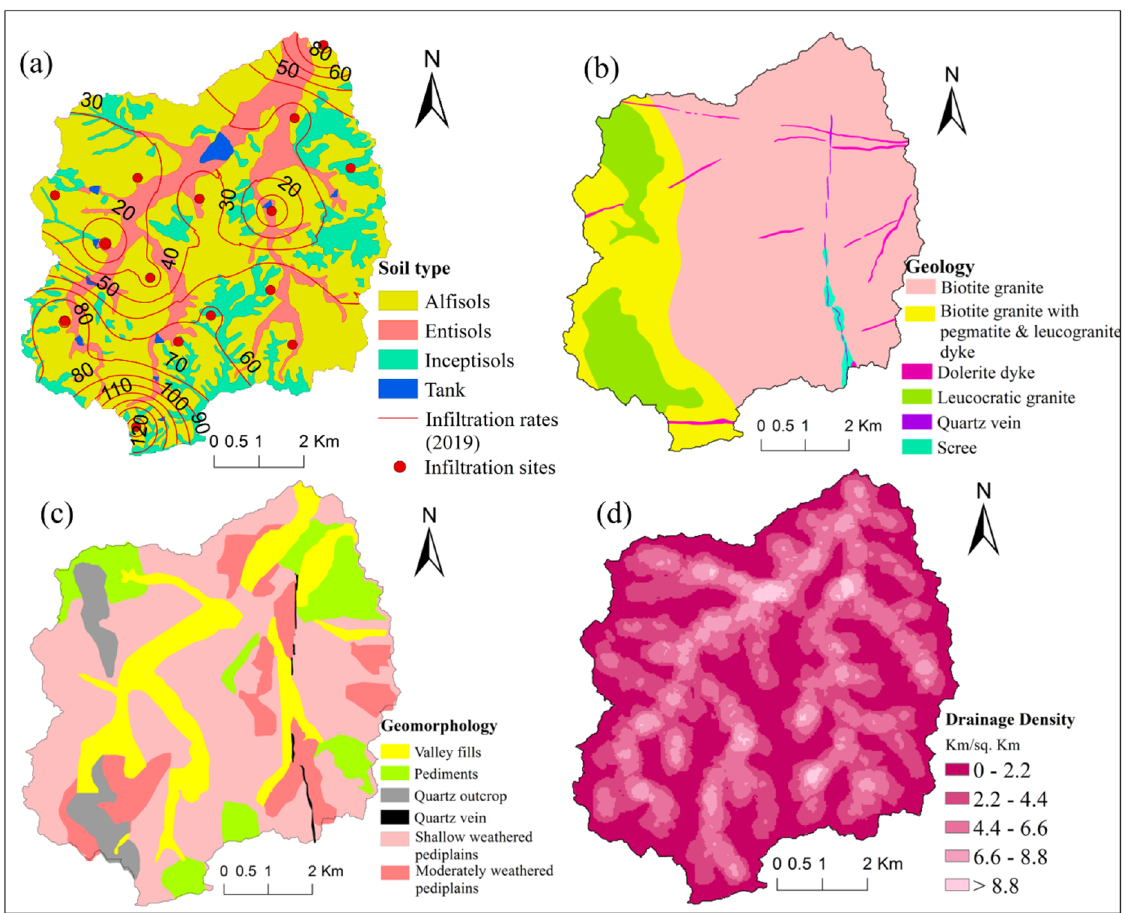
Figure 2. Map showing input thematic layers ( a ) soil with infiltration rates (mm/hr) and sites, ( b ) geology ( c ) geomorphology and ( d ) drainage density of Maheshwaram watershed, India. (ArcGIS Desktop. 10.3. ESRI, California, US. https:// deskt op. arcgis.